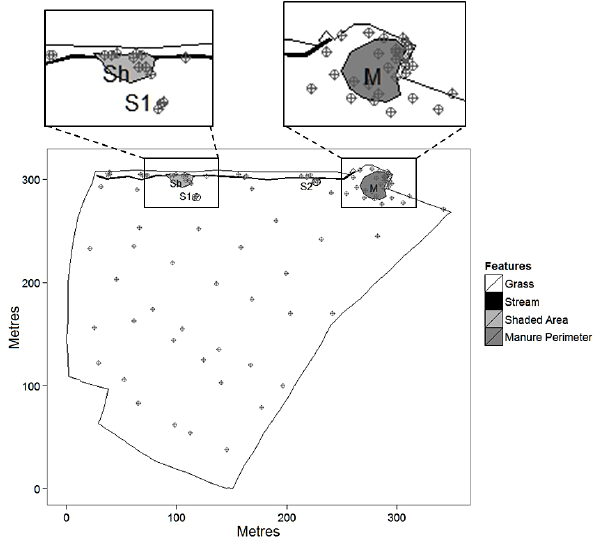
Figure 1. The locations of 100 flux measurements (markers) made over a 6.78ha grazed grassland field using the closed loop dynamic chamber method (bottom). Details of the high density measurement areas in the north of the field are expanded (top). Features present in the field are outlined, including the tree shaded area (Sh), the two small patches of silage remains (S1 & S2) and the manure heap (M). The stream runs across the north of the field through the shaded